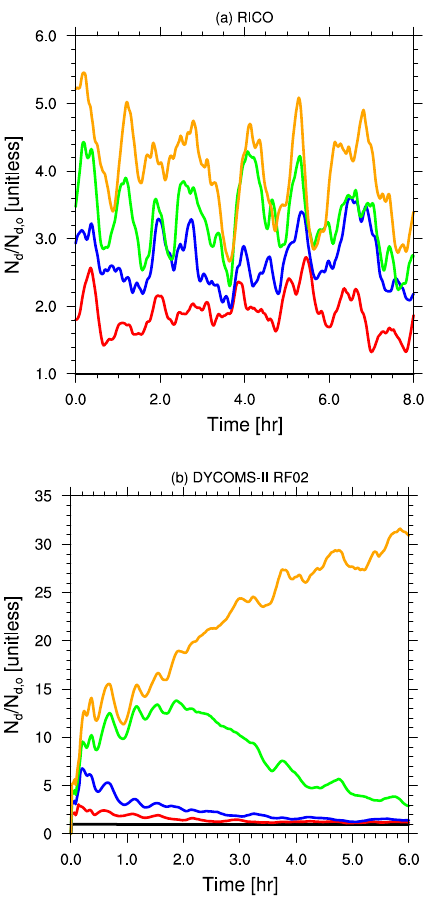
Figure 8. N d relative to N d for the lowest aerosol number concen- tration scenario (i.e., N d , 0 ) for both (a) RICO and (b) DYCOMS- II RF02 simulations. Doubling (red), tripling (blue), quadrupling (green), and quintupling (orange) N a are depicted for both sets of simulations, corresponding to N a = 200, 300, 400, and 500cm − 3 relative to 100cm − 3 , respectively, for RICO and N a = 50, 75, 100, and 125cm − 3 relative to 25cm − 3 , respectively, for DYCOMS-II